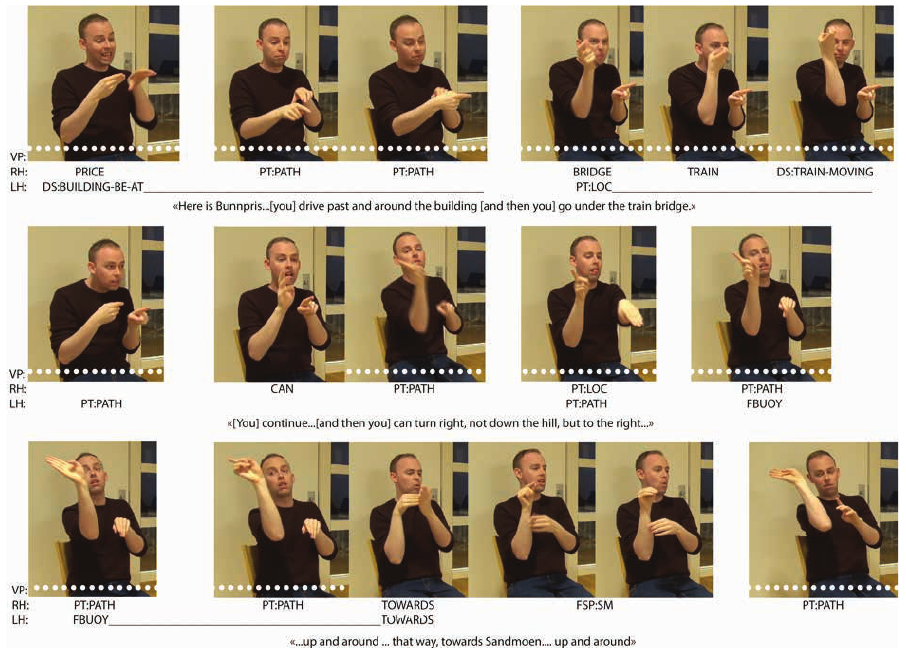
Figure 4: A signer depicting directions from an external, mobile vantage point (DPNTS_Tr_TJ.eaf, 00:11:43.489-00:11:54.102).